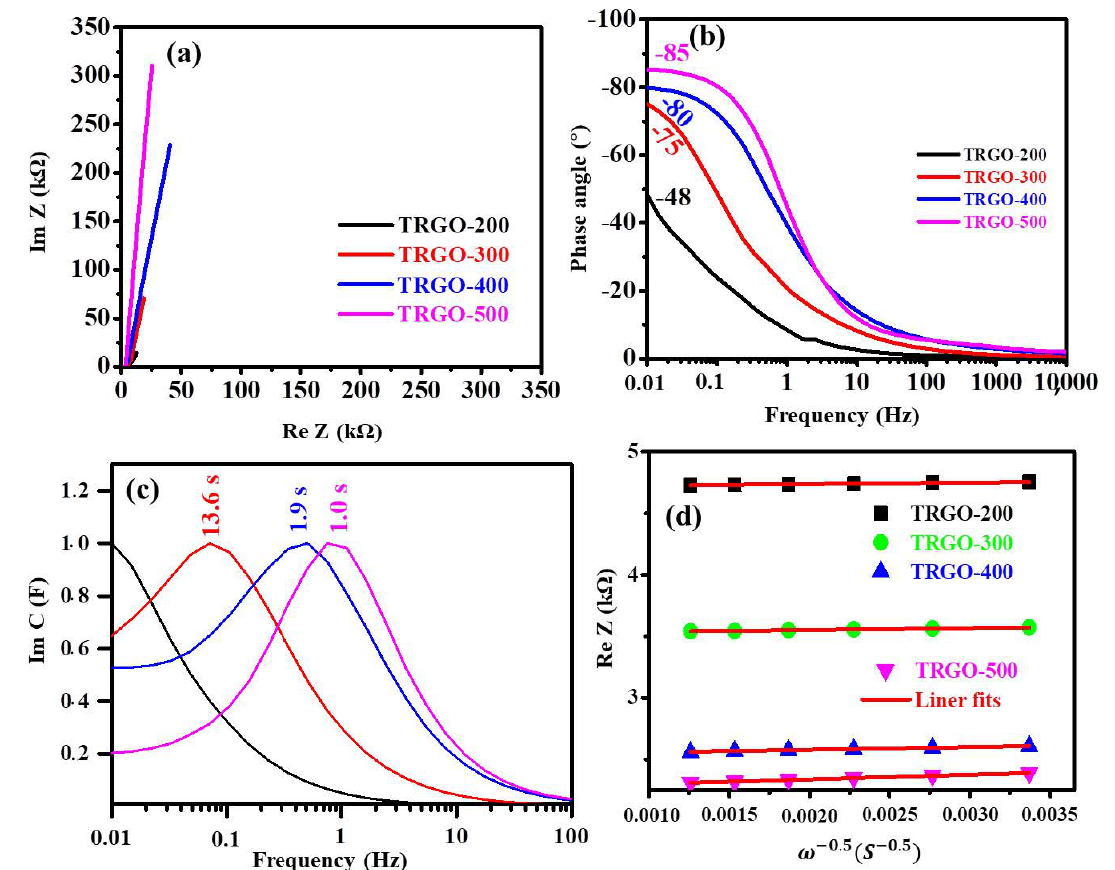
Figure 9. ( a ) EIS Nyquist plot, ( b ) phase angle versus frequency, ( c ) imaginary plot of capacitance as a function of frequency, and ( d ) real Z versus ω − 0.5 at low frequencies for the TRGO samples, as labelled in the figures.